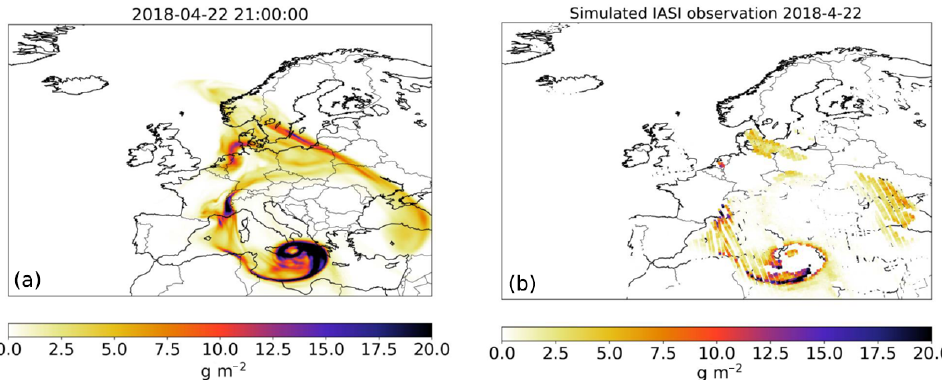
Figure 6. (a) Simulated observations based on actual IASI pixels; no retrievals if cloud cover fraction > 0 . 25 in the 0 . 1 ◦ × 0 . 1 ◦ model pixel. (b) Simulated aerosol optical depth (AOD) > 8. The values are perturbed with a spatially correlated error (the spatial correlation is based on a similar error covariance to that of the simulated MODIS AOD) – the error of each data point is set to 0.25 times the simulated value plus 0.05gm − 2